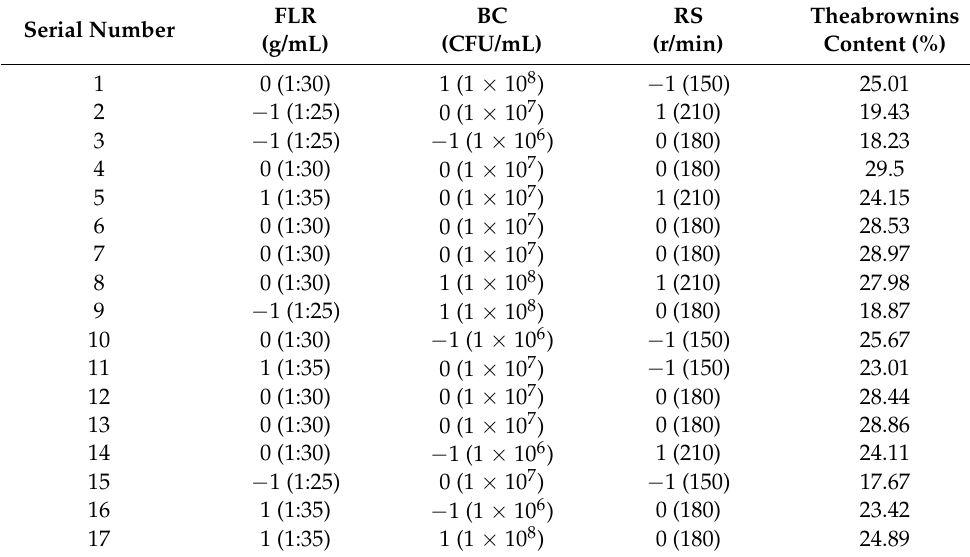
Table 5. Box–Behnken optimized design and